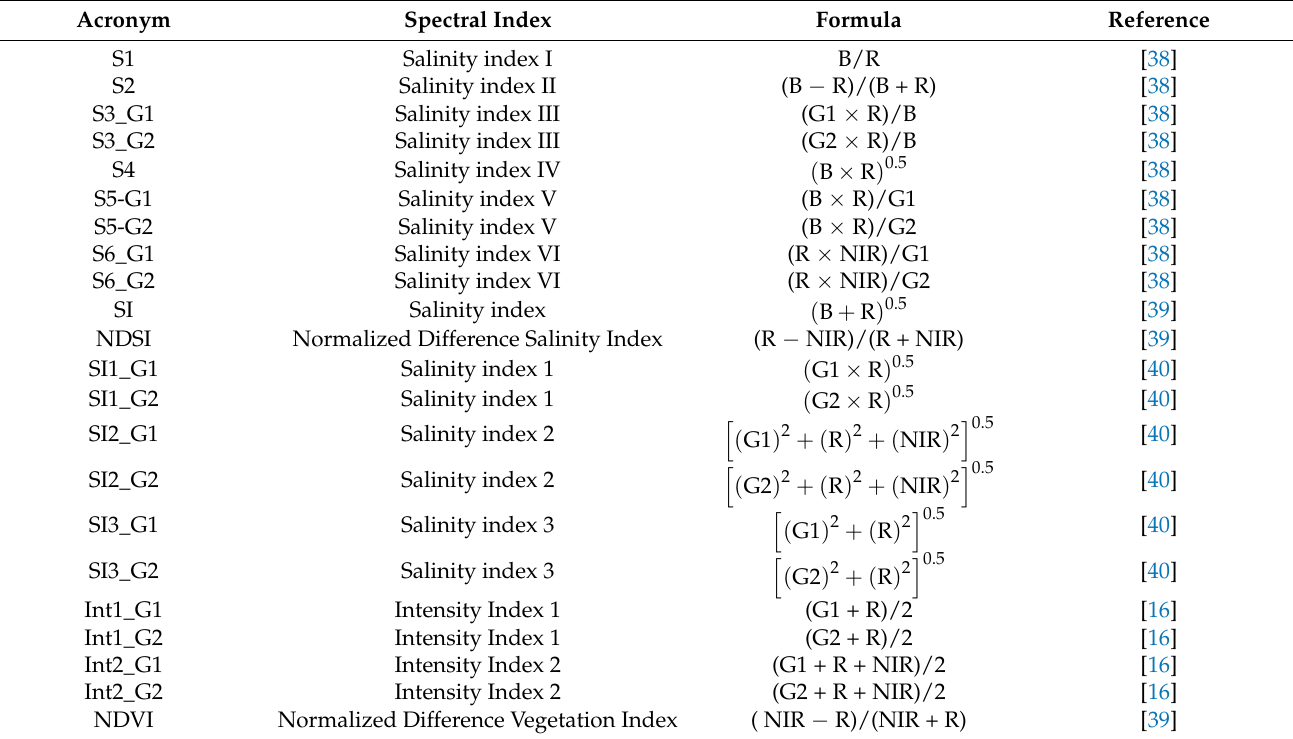
Table 2. Reference spectral salinity indices.